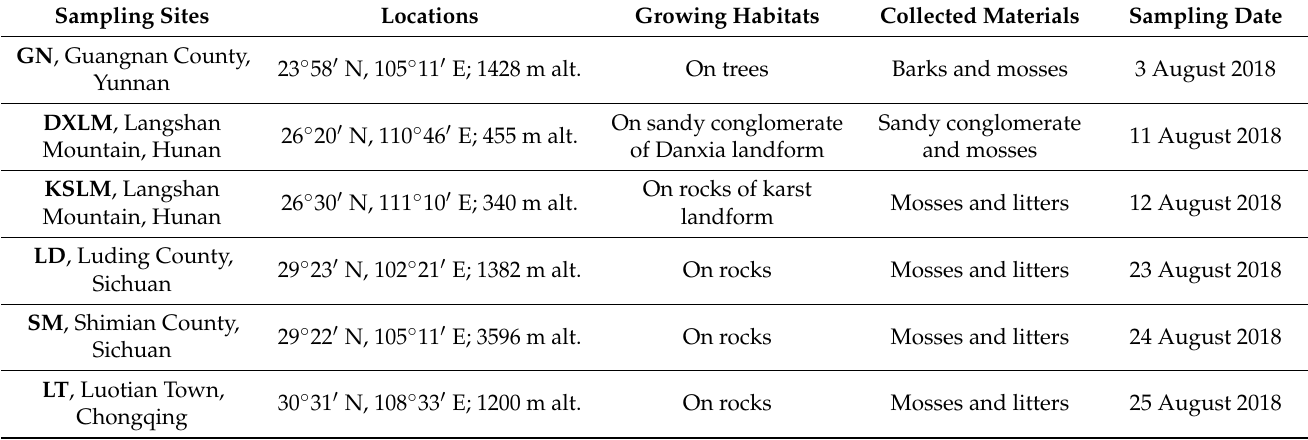
Table 1. The locations of six sampling sites with information about the growing habitats of Dendrobium officinale plants, materials collected for ex situ seedling baiting experiments and sampling dates. Locations Growing